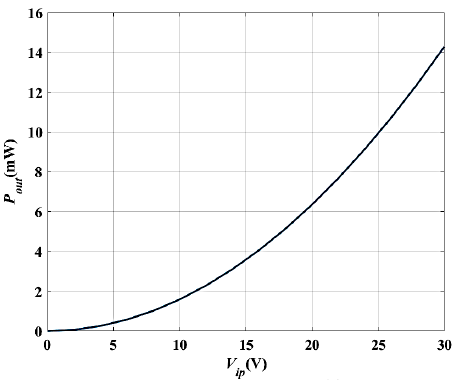
Figure 15. Simulation results of the proposed converter output power with the input voltage.